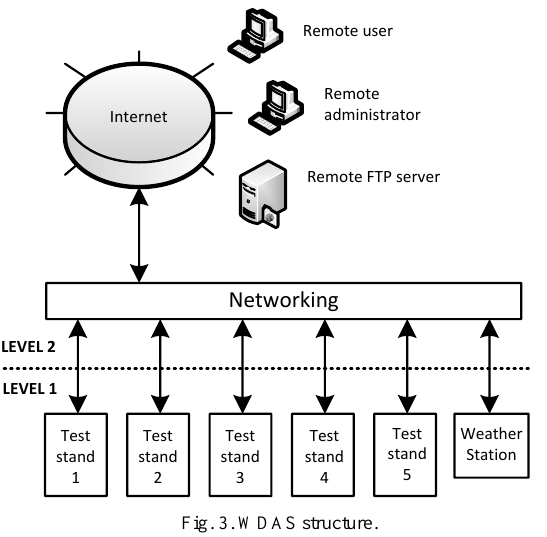
Fig. 3. WDAS structure.